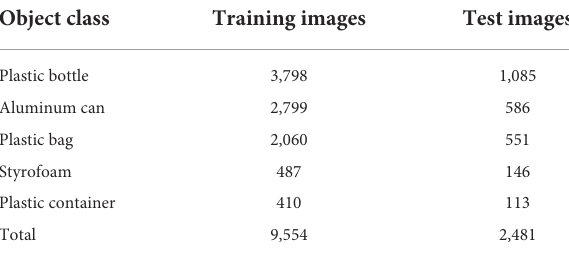
TABLE 1 The training and test